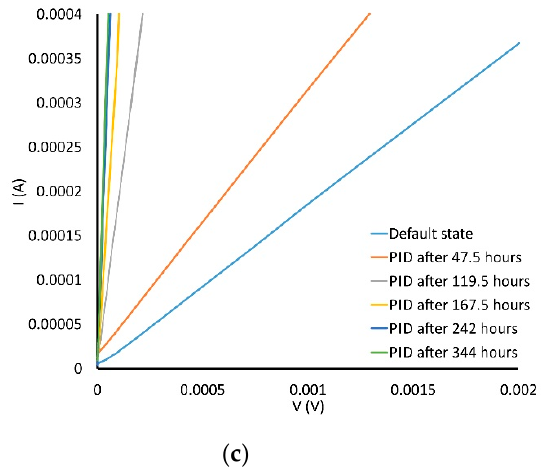
Figure 8. ( a ) I-V curves during degradation for PV cell. ( b ) Cole-Cole curve during degradation for PV cell. ( c ) Dark I-V curve during degradation for PV cell.